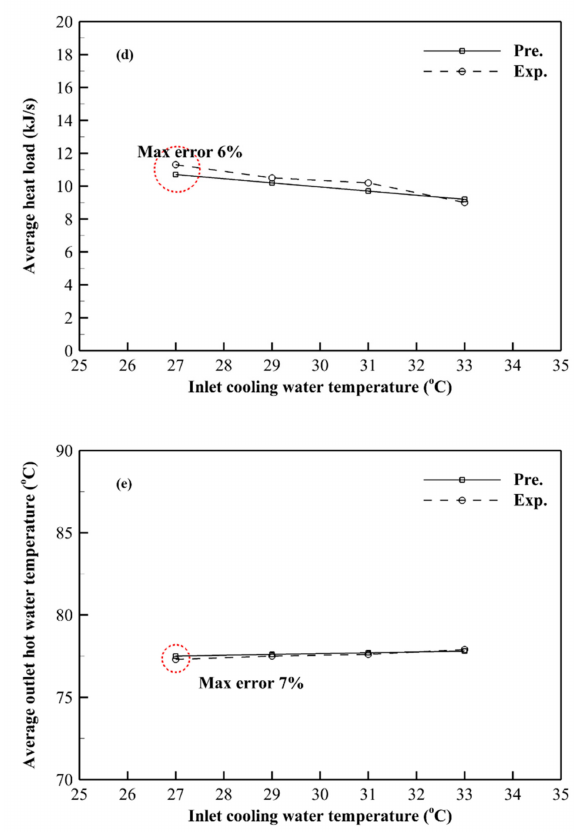
Figure 5. Comparison study between experimental results and predicted results: ( a ) coe ffi cient of performance (COP); ( b ) cooling capacity; ( c ) average outlet chilled water temperature; ( d ) average heat load; and ( e ) average outlet hot water